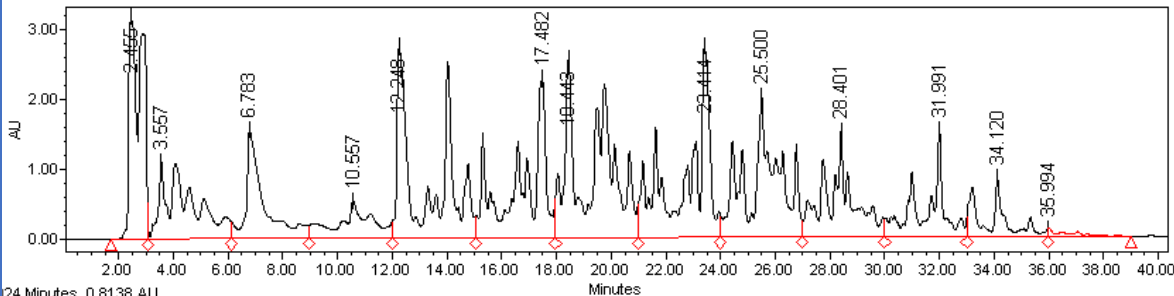
Figure 3. Chromatographic example of a peptide pro fi le of a digested cheese.